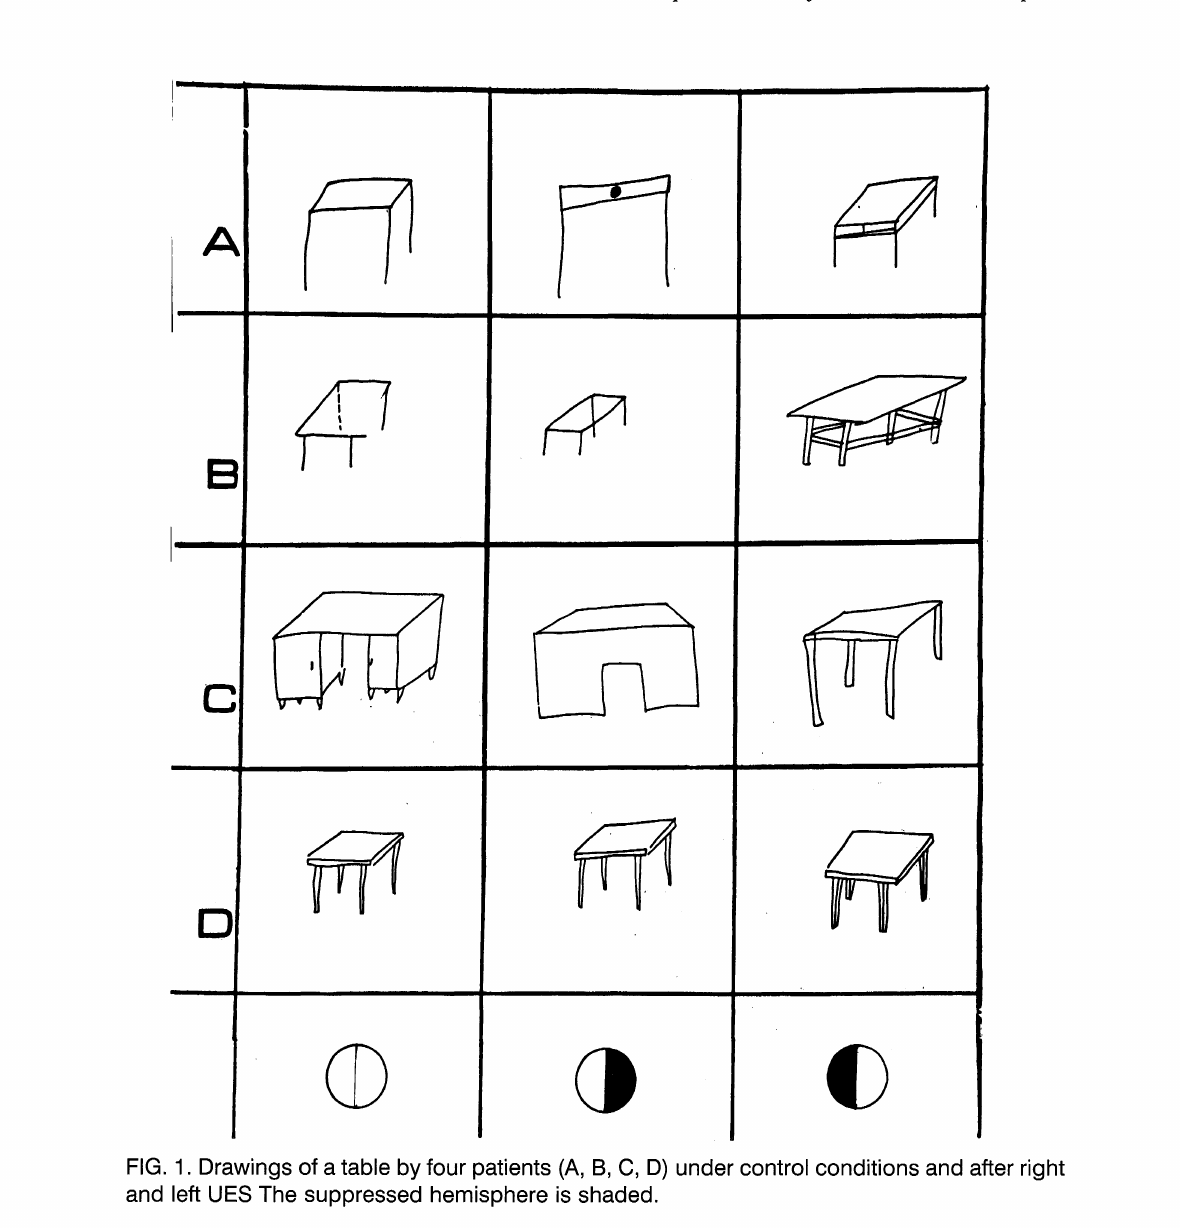
FIG. 1. Drawings of a table by four patients (A, S, C, D) under control conditions and after right and left UES The suppressed hemisphere is